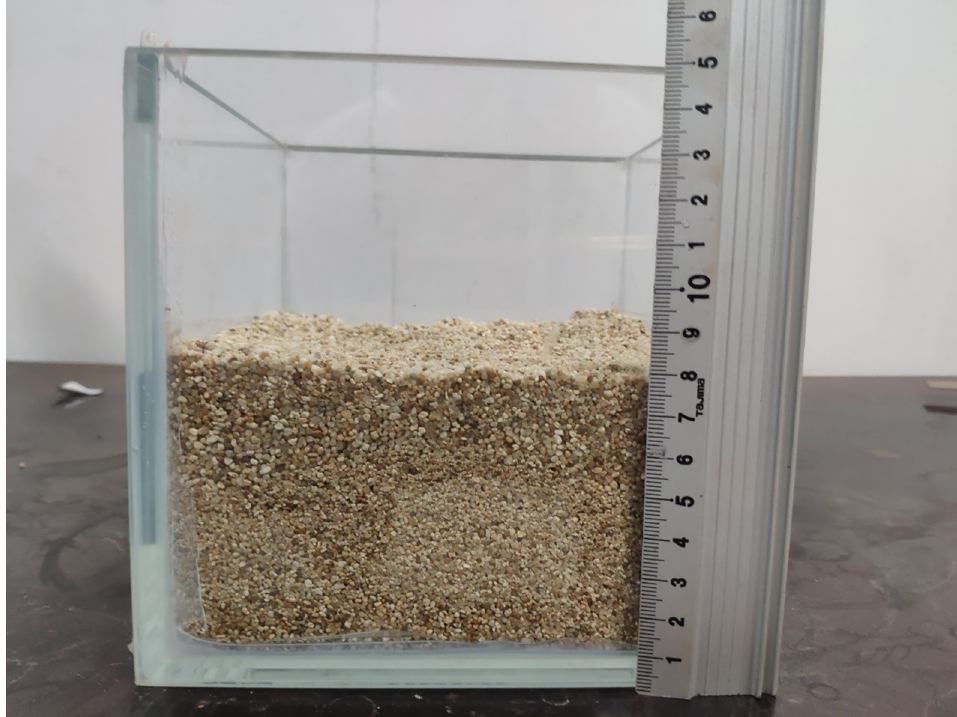
Fig 8. Simulated formation